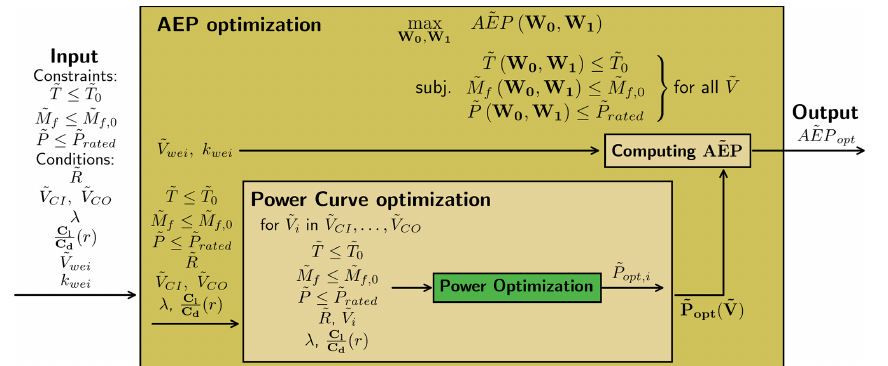
Figure 4. Flowchart for the AEP optimization. The optimization is simply a power optimization for each wind speed in the power